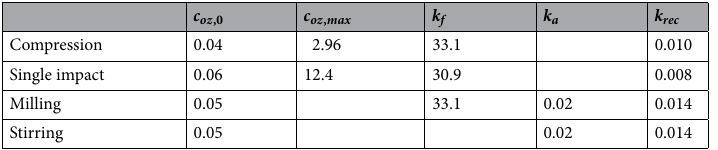
Table 1. Parameter values used to best-fit the experimental data obtained in different experiments. The model parameters considered are background O 3 level, c oz ,0 (mmol m −3 ), the maximum O 3 concentration measured after fracture processes induced by uniaxial compression of granite cubes and individual impacts on granite coarse powder, c oz , max (mmol m −3 ), the amount of O 3 generated by fracture per unit surface area, k f (μmol m −2 ), the amount of O 3 generated by attrition per unit surface area, k a (μmol m −2 ) and the O 3 recombination rate, k rec (s −1